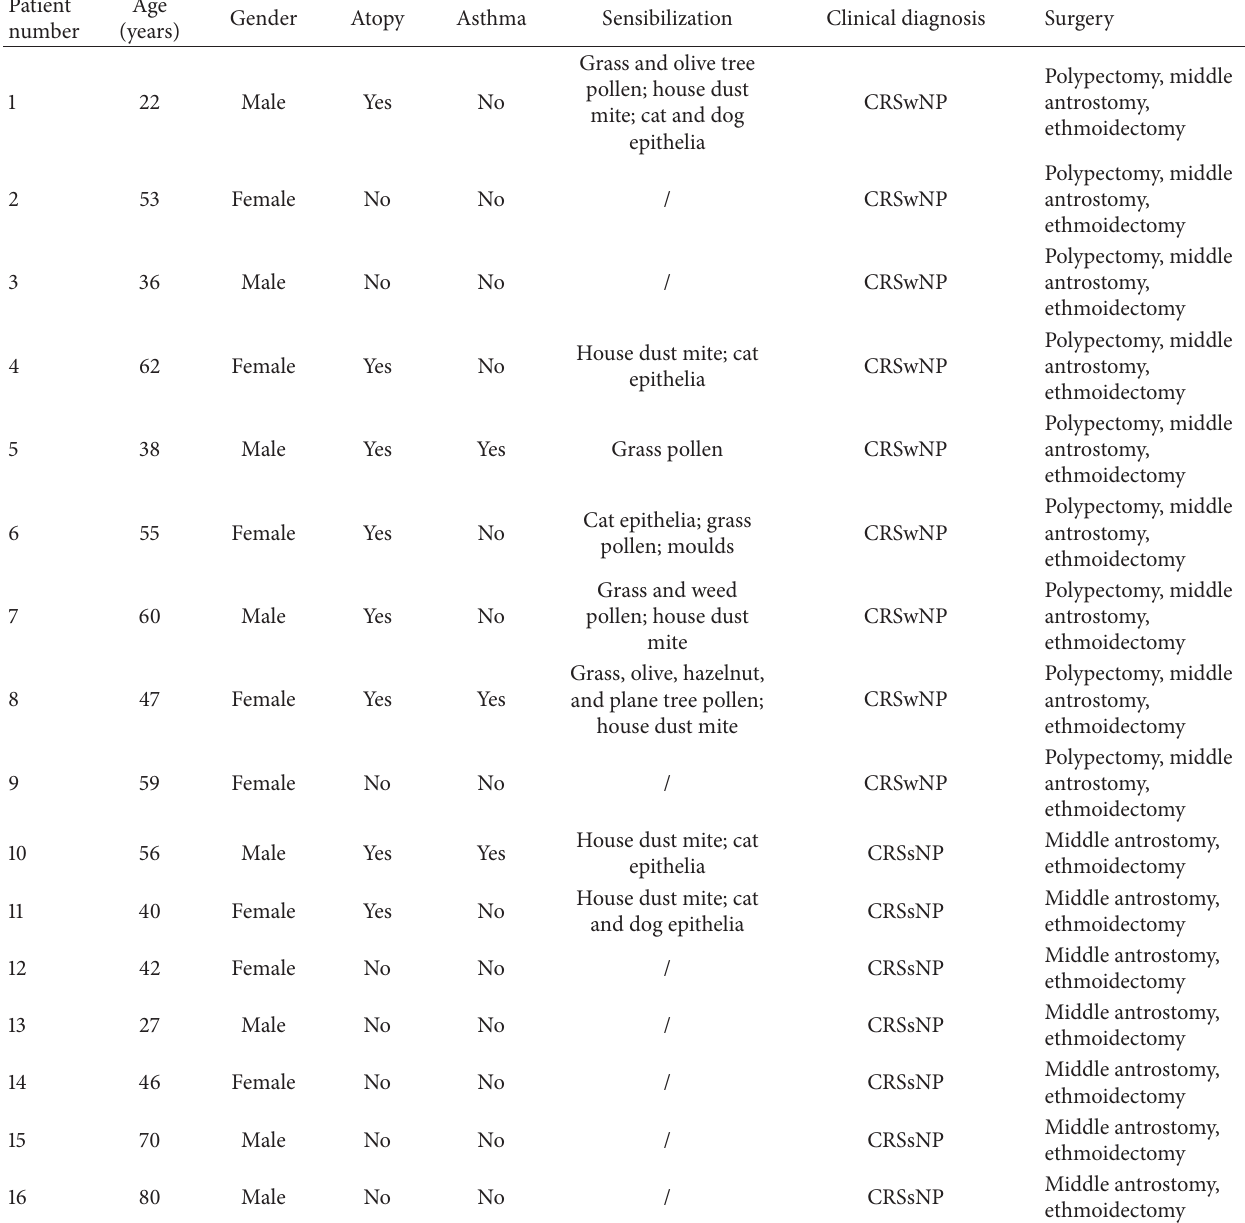
Table 1: Demographic and clinical characteristics of